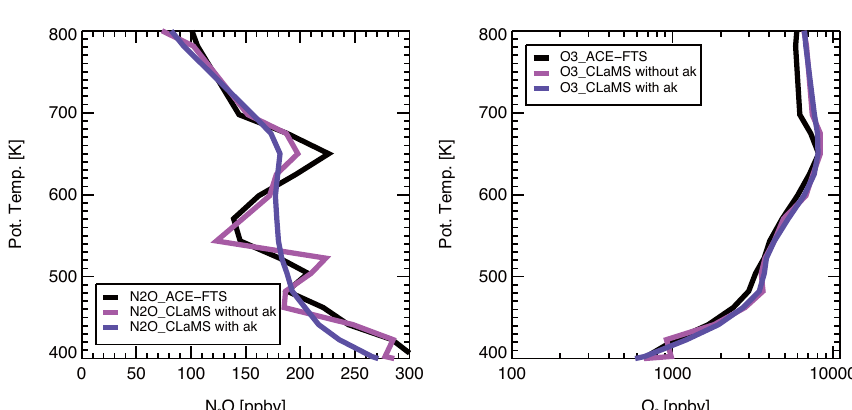
Figure A3. N 2 O (top) and O 3 (bottom) profiles of ACE observations (black) on 20 February located at 73.05 ◦ N, 137.11 ◦ W at 30km, and of corresponding CLaMS simulation before (blue) and after (purple) applying the MLS averaging